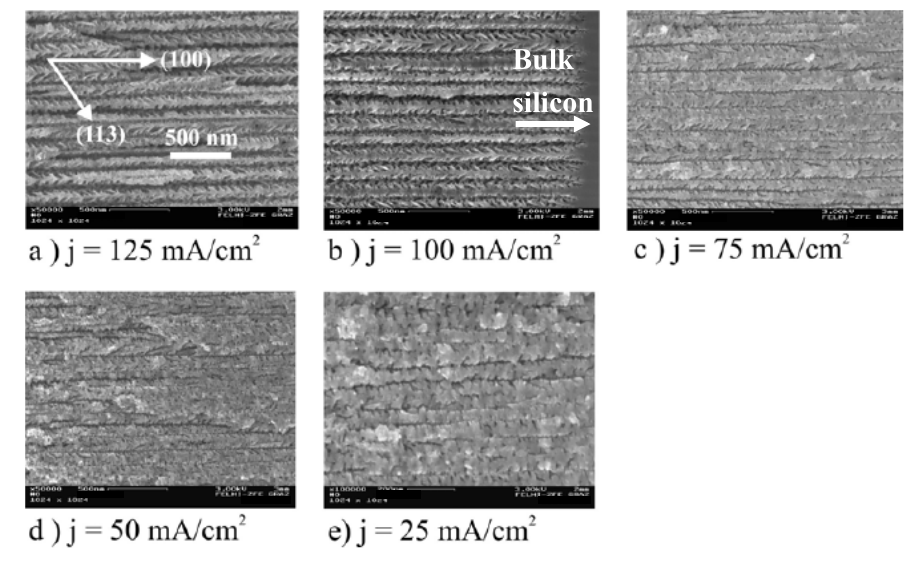
Figure 10. Corresponding cross-sections of the images Figure 3a–3e [83]. The pore- diameter decreases from ~95 nm to ~25 nm. Images a, c, d, e show cross sectional views in the mid of the porous layer. In image (b) a region near the pore tips is